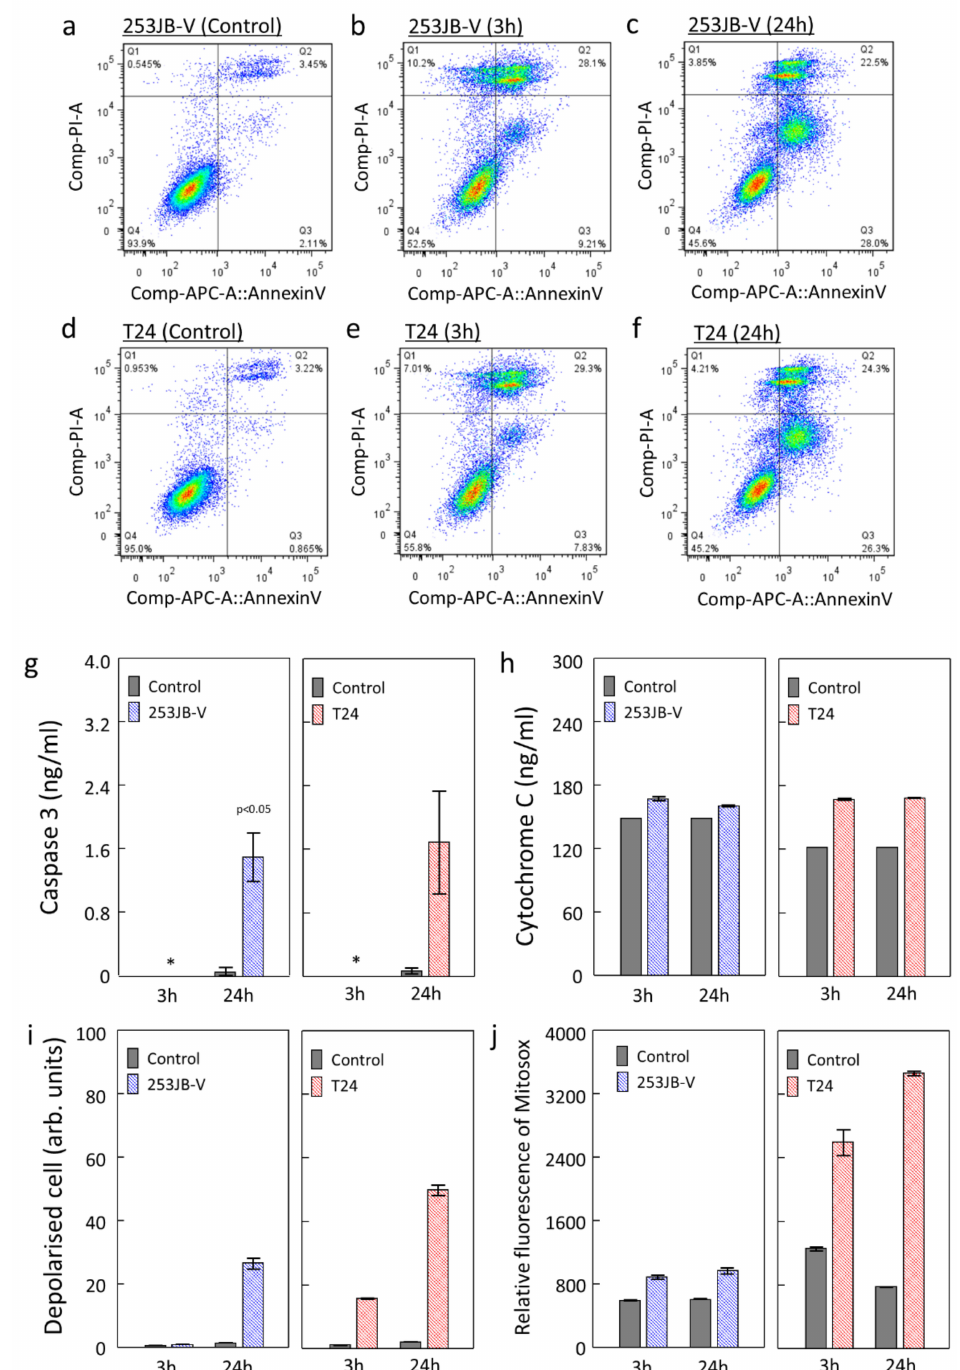
Figure 2. Mechanism of cell death induced by PAM treatment of bladder cancer cells. Flow cytometry graphs of 253JB-V bladder cancer cells stained with V-APC and PI ( a ) before PAM treatment (untreated control) and at ( b ) 3 h and ( c ) 24 h after PAM treatment; and T24 bladder cancer cells stained with V-APC and PI ( d ) before PAM treatment (untreated control) and at ( e ) 3 h and ( f ) 24 h after PAM treatment. Concentrations of ( g ) caspase 3 (* data not available for the 3 h timepoint subset) and ( h ) cytochrome c in bladder cancer cells before (untreated control) and after PAM treatment. ( i ) Percentage of depolarised bladder cancer cells determined through measurement of the ∆Ψ m before (untreated control) and after PAM treatment. ( j ) Relative fluorescence of Mitosox to determine the relative level of mitochondrial ROS produced in bladder cancer